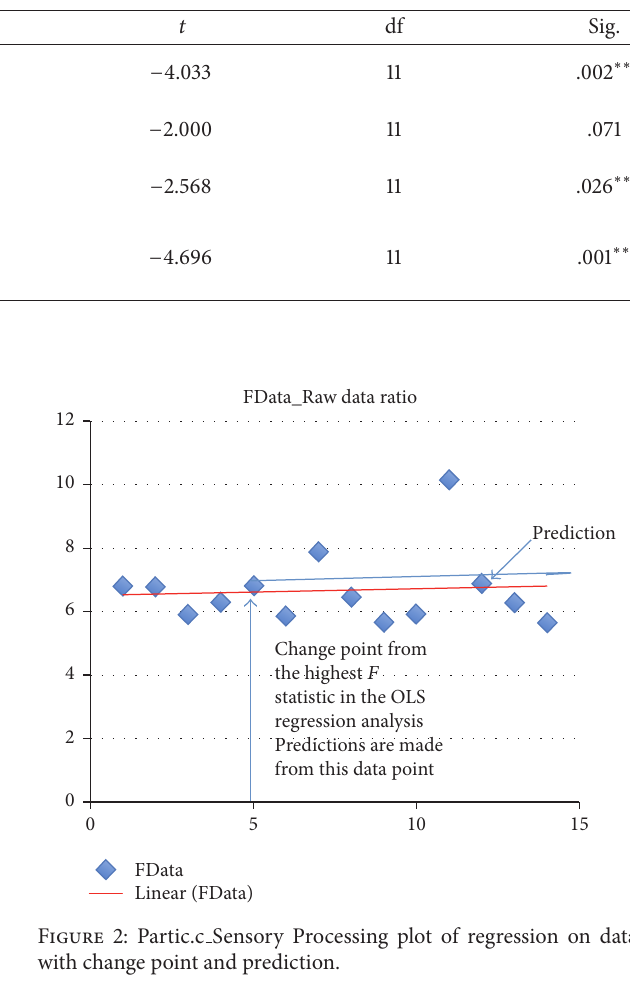
Table 1: Paired 𝑡 -test results of the HEAT pretest/posttest results.